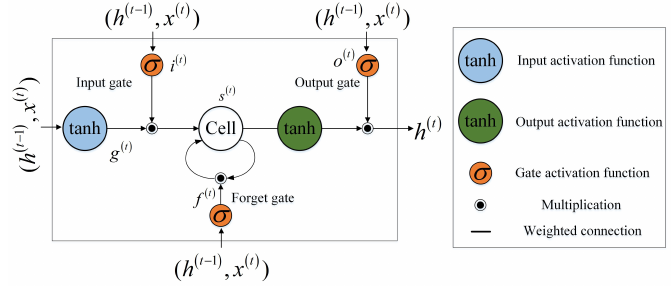
Figure 2. The architecture of a long short-term memory (LSTM) memory